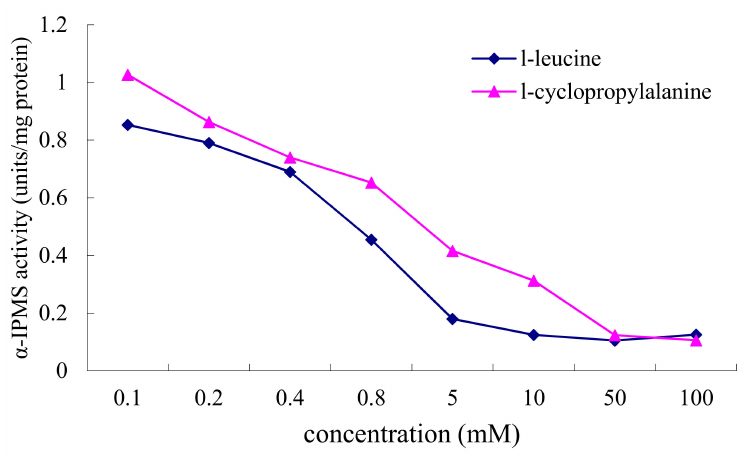
Figure 5. Inhibition of α -IPMS by L -leucine and L -cyclopropylalanine.